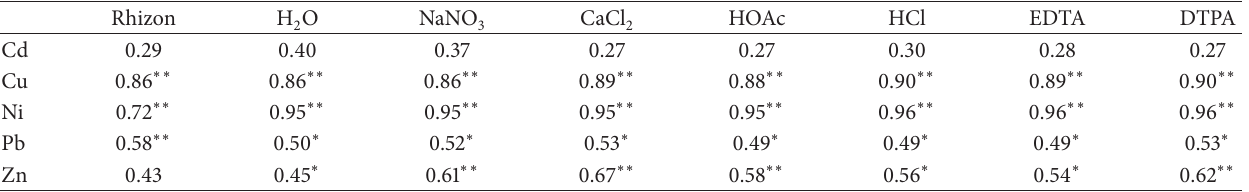
Table 8: Coefficients of determination ( 𝑟 2 ) obtained by multiple linear regression ( 𝑛 = 17 for Cd and Pb; 𝑛 = 18 for Cu, Ni, and Zn).